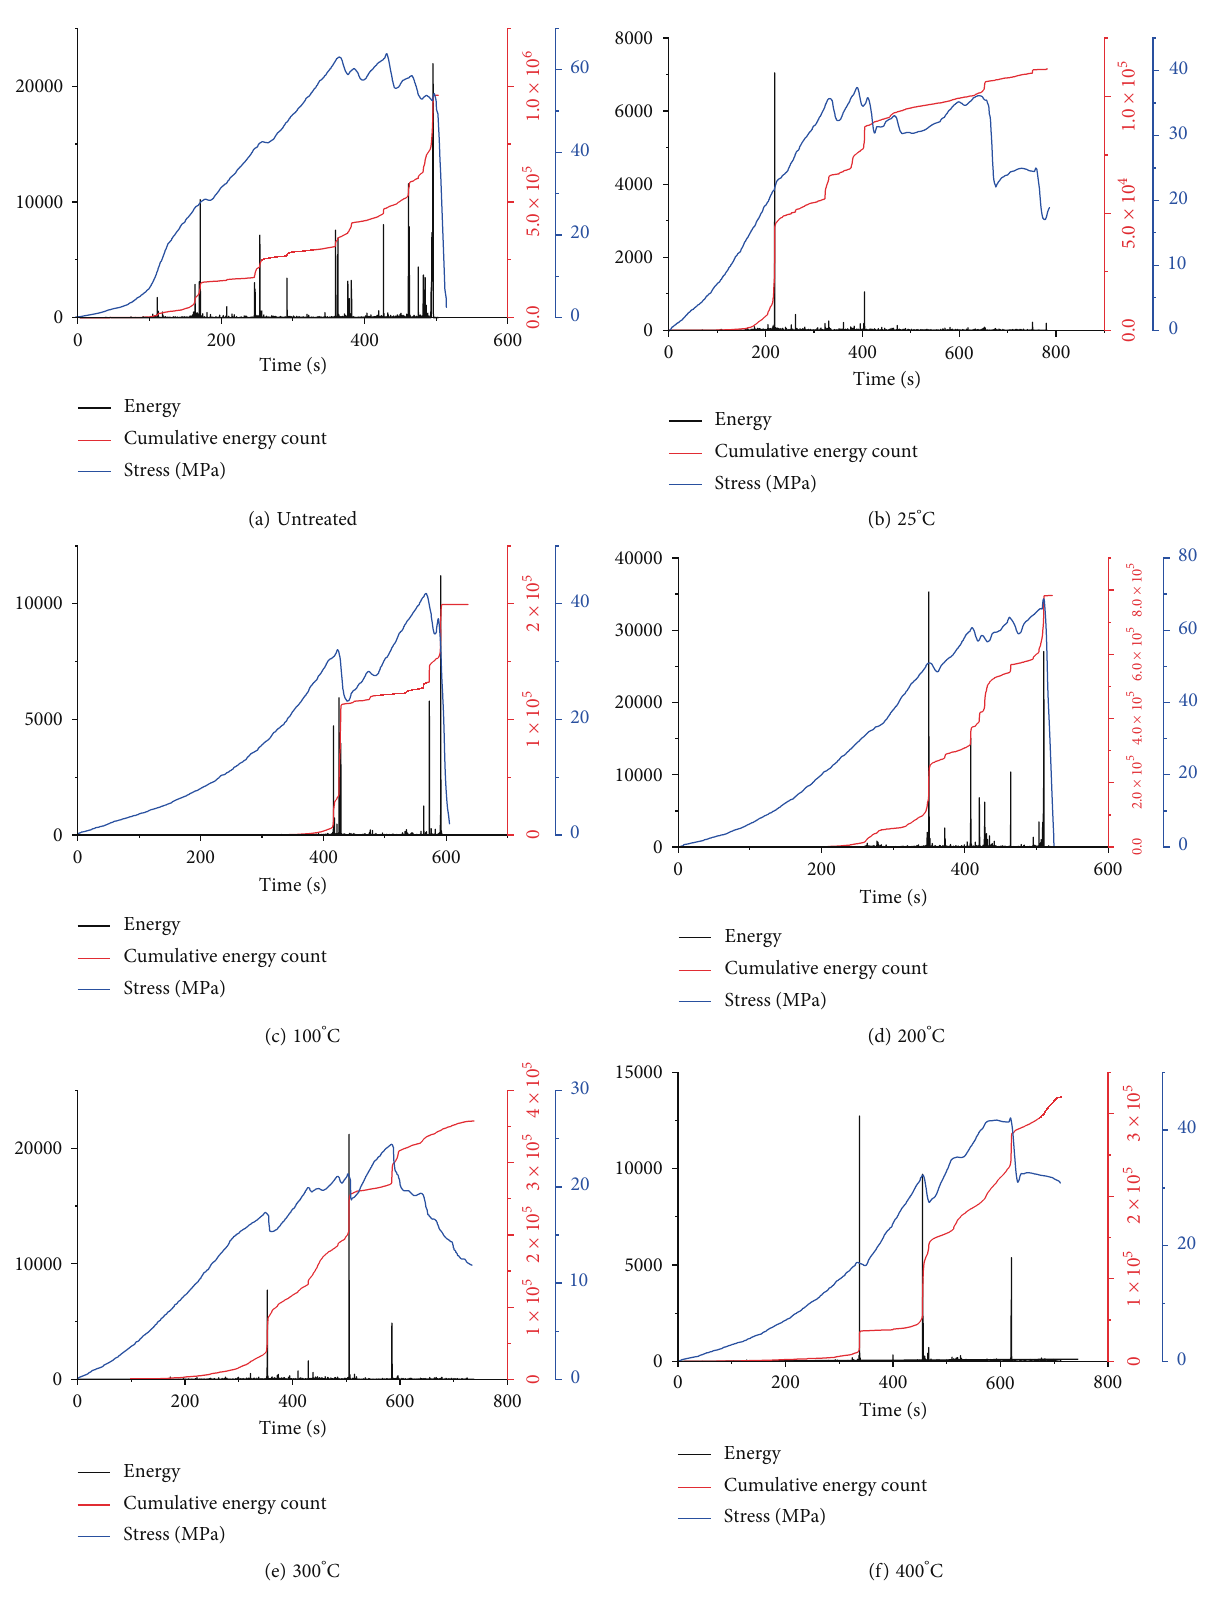
Figure 11: The variation of stress, energy count, and cumulative energy count of granite with time under di ff erent initial